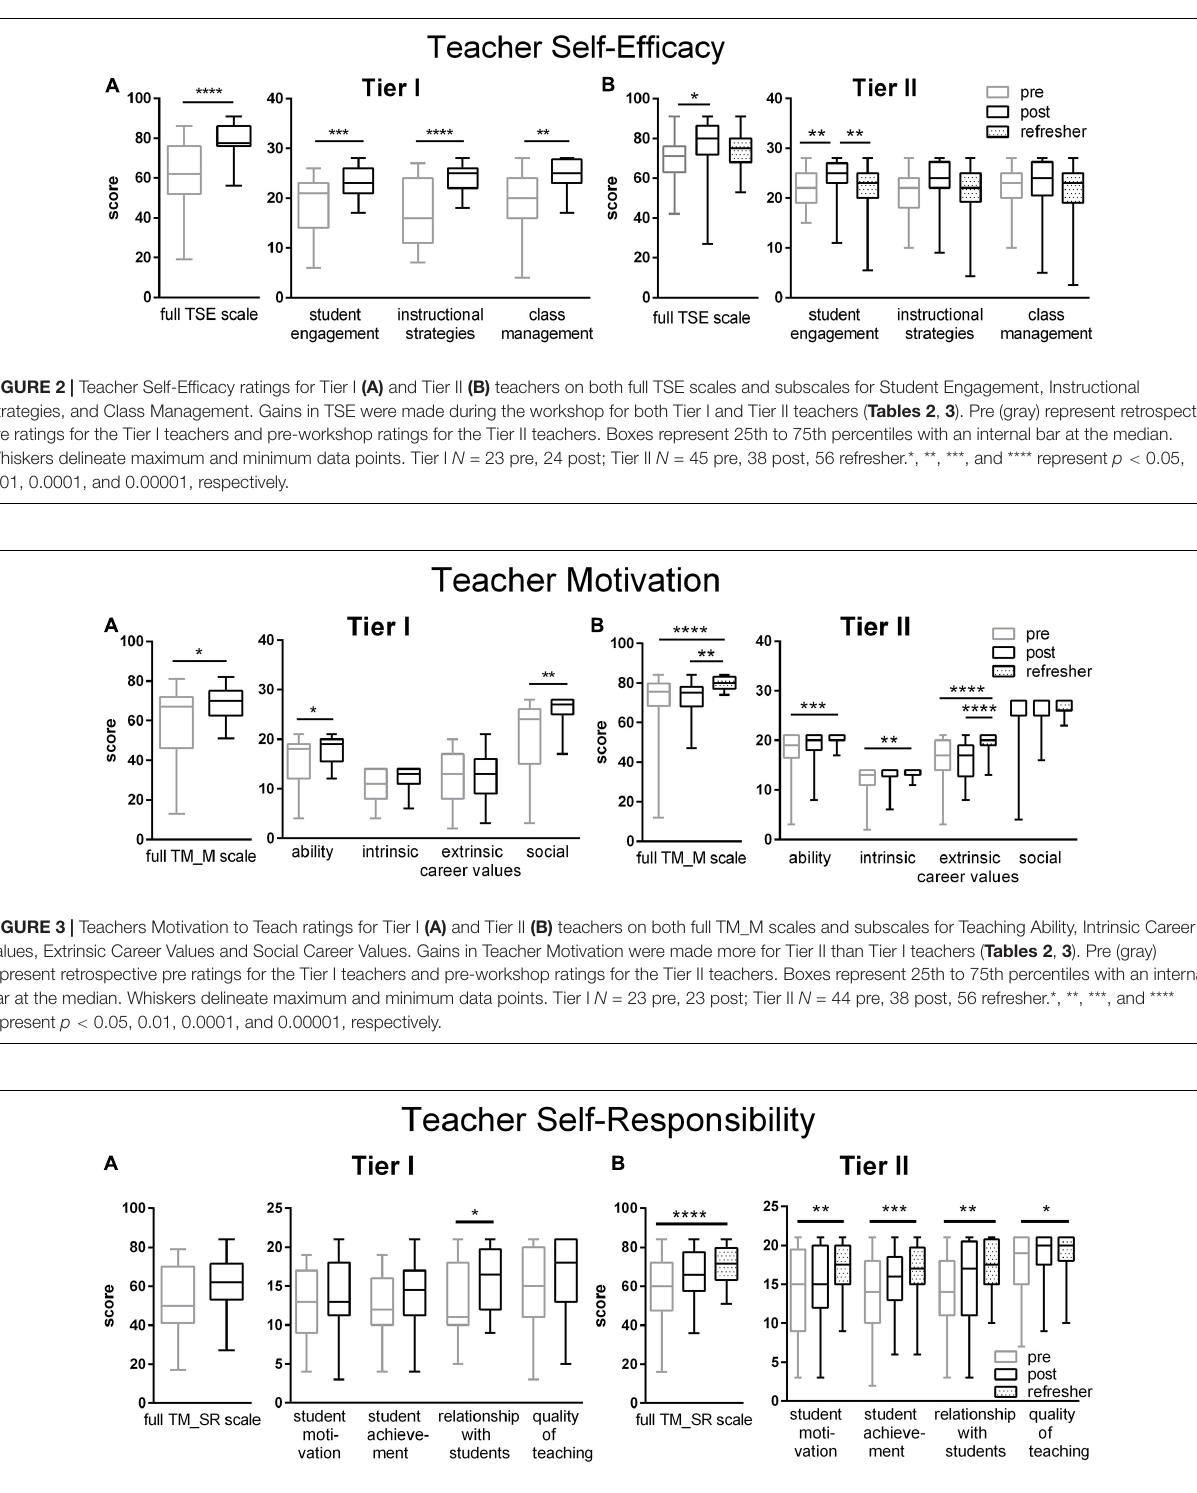
FIGURE 4 | Teachers Self-Responsibility for Teaching ratings for Tier I (A) and Tier II (B) teachers on both full TM_SR scales and subscales for student motivation, student achievement, relationships with students and quality of teaching. Gains in Teacher Self-Responsibility were principally made for Tier II teachers at the Refresher time point ( Tables 2 , 3 ). Pre (gray) represent retrospective pre ratings for the Tier I teachers and pre-workshop ratings for the Tier II teachers. Boxes represent 25th to 75th percentiles with an internal bar at the median. Whiskers delineate maximum and minimum data points. Tier I N = 22 pre, 24 post, Tier II N = 41–44 pre, 38 post, 56 refresher. For the post tests, *, **, ***, and **** represent p < 0.05, 0.01, 0.001, and 0.0001,